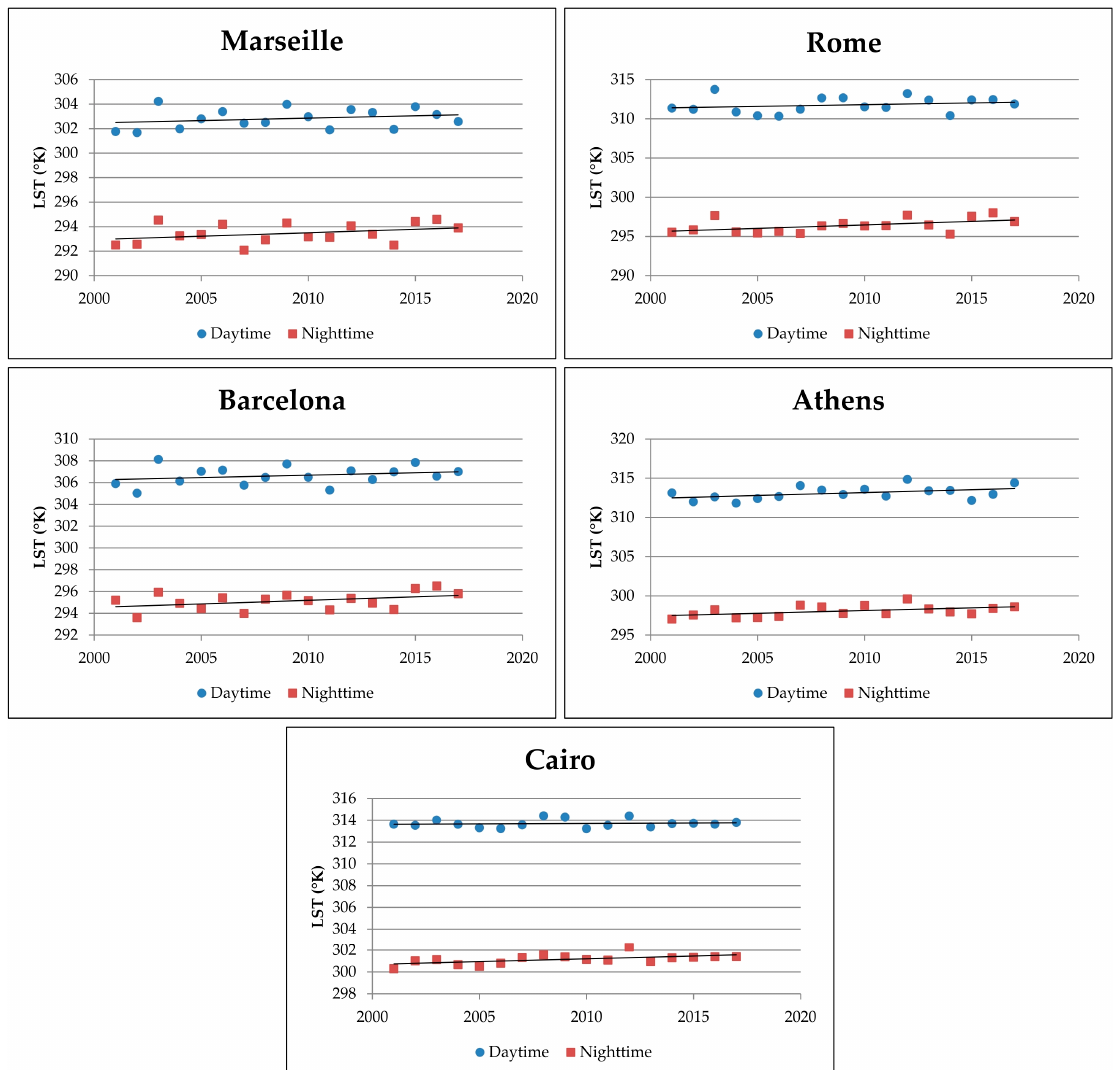
Figure 6. Time series of daytime and nighttime LSTs. The LSTs correspond to one selected pixel per city that it is located at the urban core and exhibits high positive LST trend as it can be seen in Figures 3 and